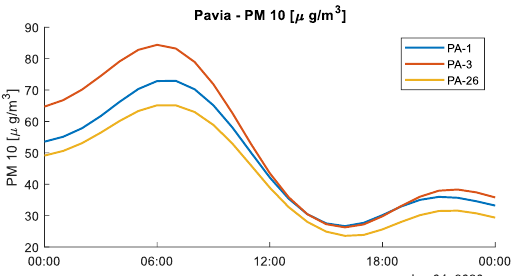
Figure 8. PM 10 for the three mentioned stations and for January 4 th , 2019; graphic highlights strong intra-day variability